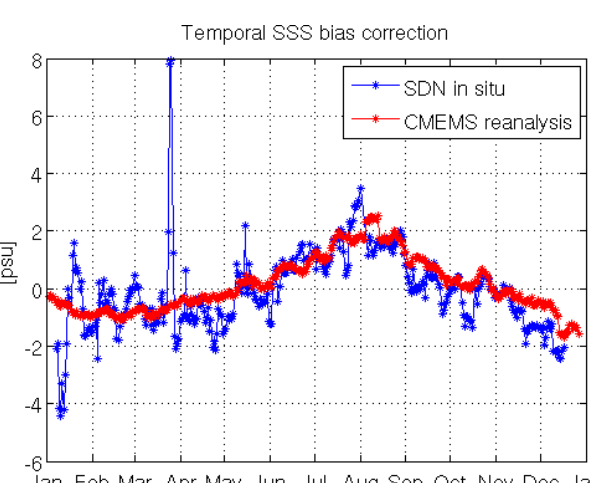
Figure 9. Temporal bias correction computed for the SSS product during 2013 by using the CMEMS Baltic reanalysis (red) and SDN in situ measurements (blue). Note that the peaks in the correction computed from SDN in situ measurements are due to the very scarce and fragmentary spatial distribution of collocated in situ